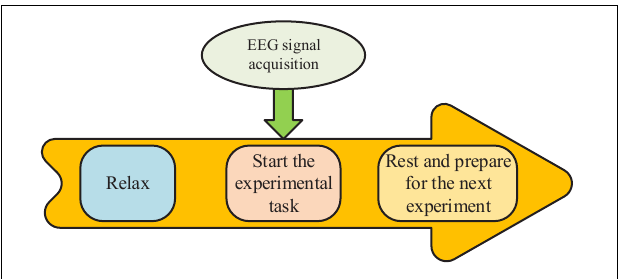
FIGURE 3 | Experimental